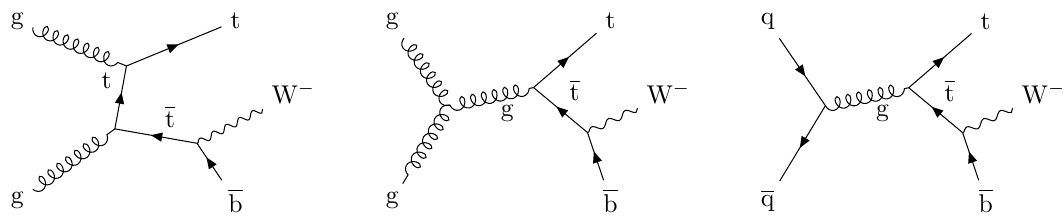
Figure 2 . Feynman diagrams for tW single top quark production at next-to-leading order that are removed from the signal definition in the DR scheme. Charge conjugate states are